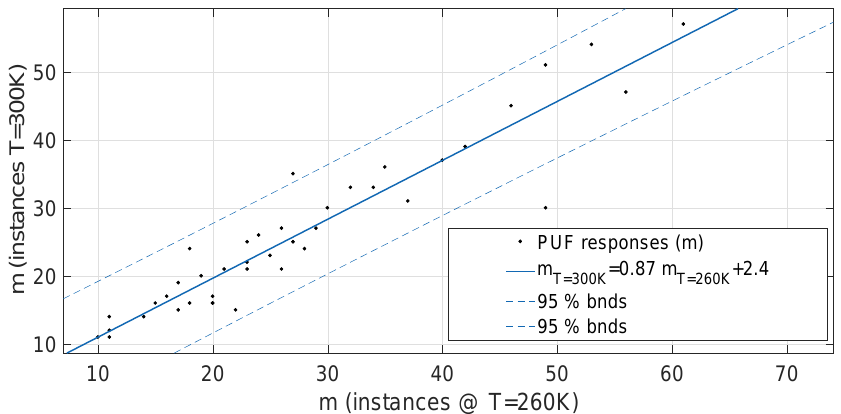
Figure 13. Regression of generated m values (PUF) keys in the same instances under different operating